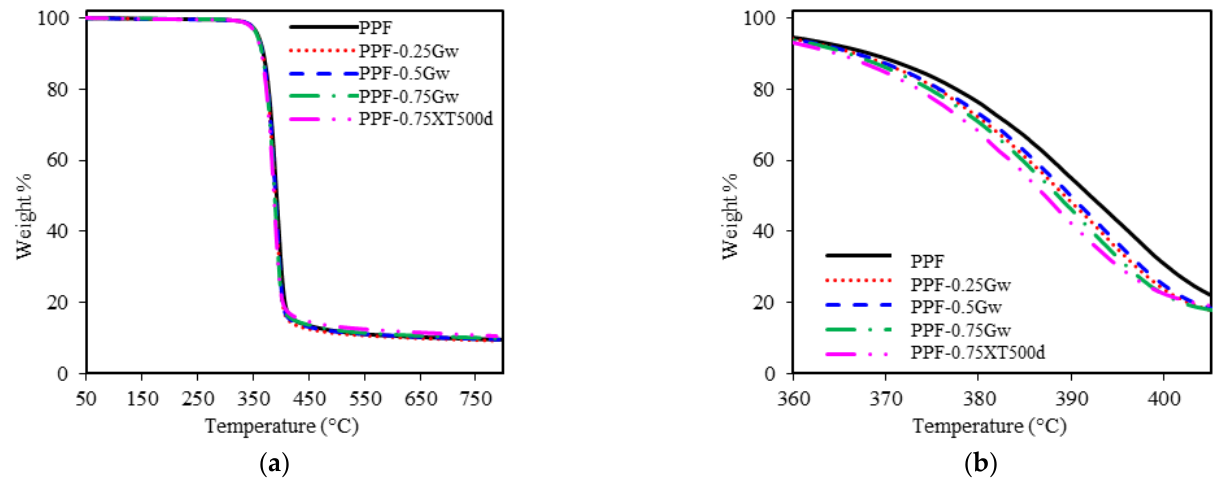
Table 2. Thermal relevant data of PPF and PHF homopolymers and nanocomposites